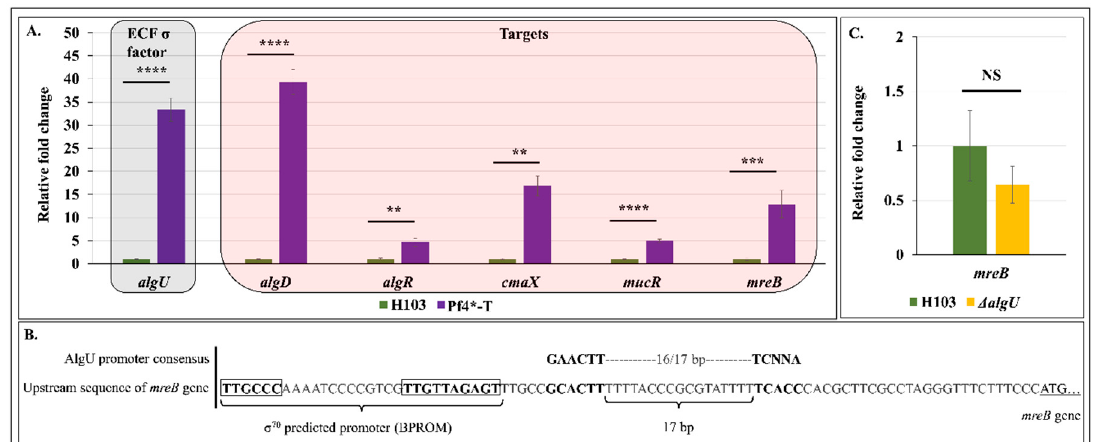
Figure 6. Pf4 phage variant infection leads to an AlgU-mediated cell envelope stress response in H103 strain. ( A ). Relative mRNA expression of algU , algD, algR , cmaX, mucR and mreB in H103 (green bars) and Pf4*-T (violet bars) conditions as determined by RT-qPCR experiments. ( B ). Sequence of the DNA region upstream of mreB showing a predicted AlgU-dependent promoter and σ 70 -dependant promoter. ( C ). Relative mRNA expression levels of mreB in P. aeruginosa H103 (green bar) and ∆ algU (yellow bar) as determined by RT-qPCR experiments. Each experiment was assayed at least four times independently. Statistics were achieved by paired (two samples) two-tailed t -test. NS p > 0.05; ** p < 0.01; *** p < 0.001; **** p < 0.0001.